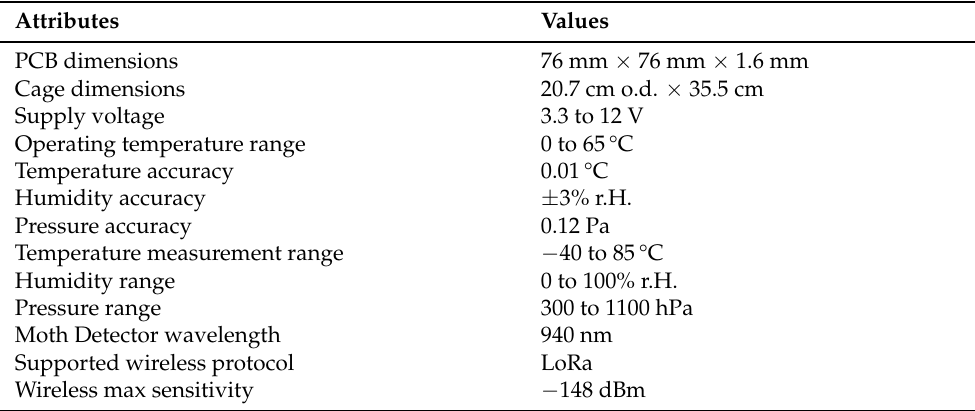
Figure 5. A diagram of the system in its two presented configurations. Table 2. System